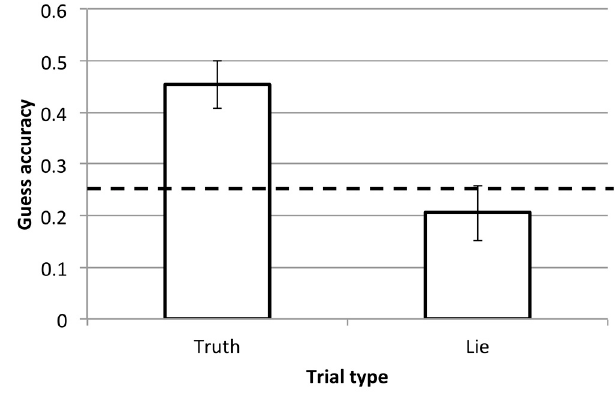
Figure 2. Accuracy from the guess block in Experiment 1. Bars show the mean, with standard error bars, for trials from each block. The dashed line indicates chance performance.